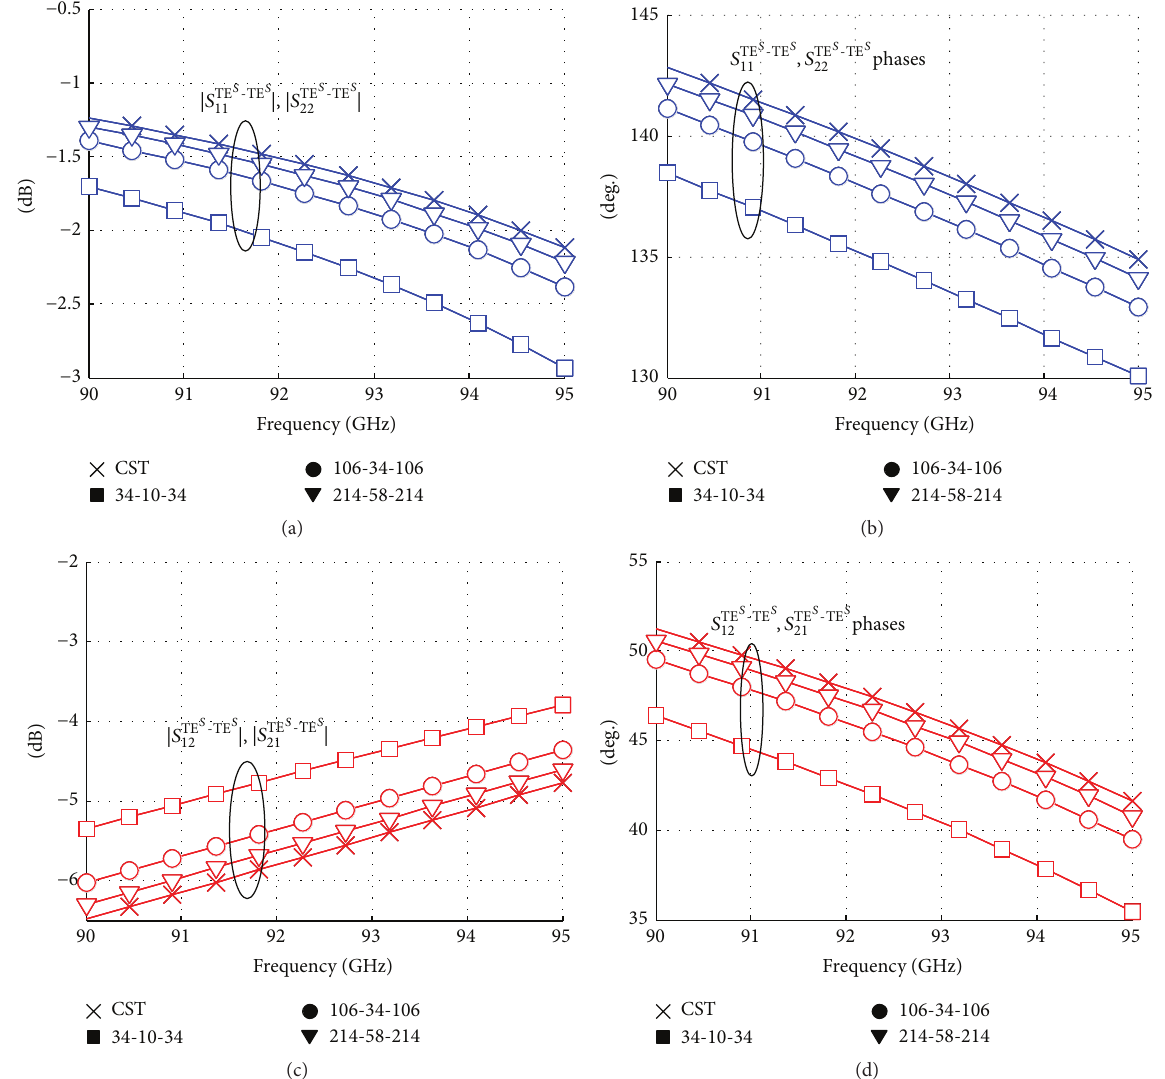
Figure 13: Case study c: mode TE 𝑆 10 in waveguide 1 to mode TE 𝑆 10 in waveguide 2 : (a) reflection magnitude, (b) reflection phase, (c) transmission magnitude, and (d) transmission